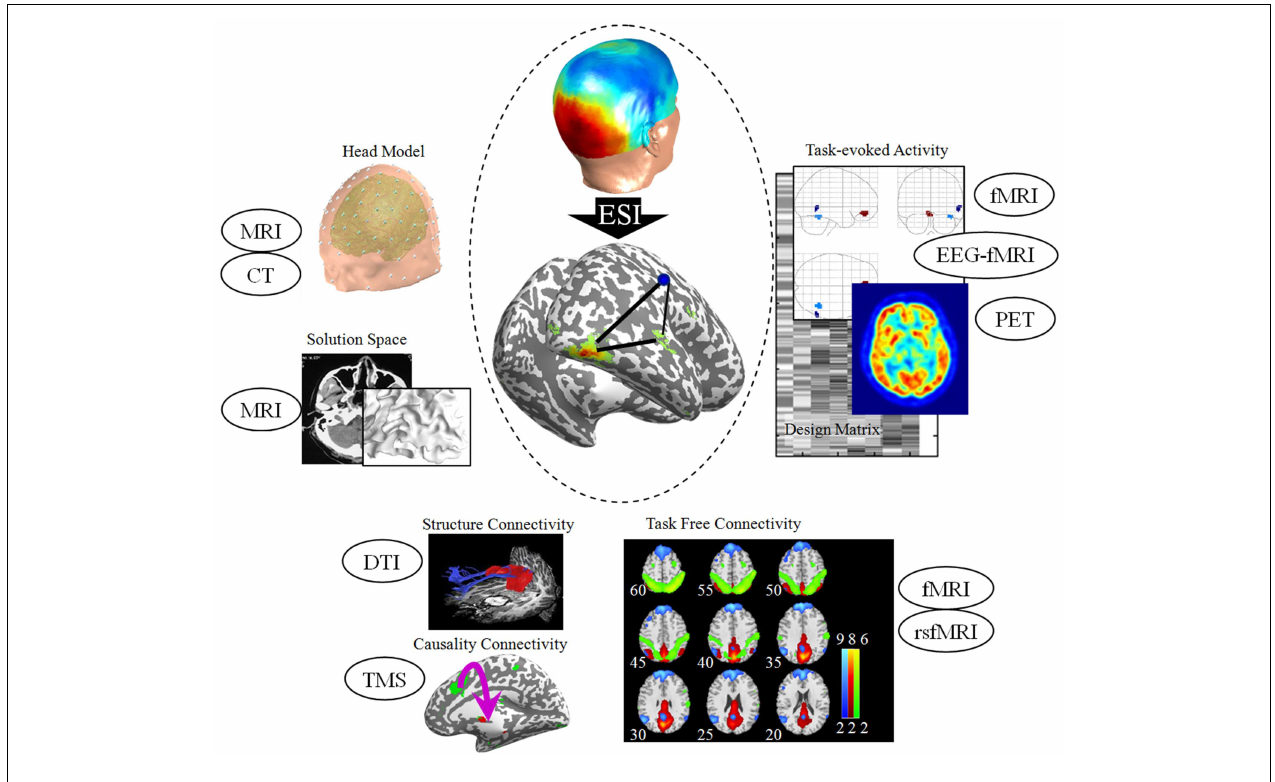
space. The TMS alters cortical excitability, effective connectivity, and oscillatory tuning of a given cortical area, and hence provides both spatial and connectivity priors for ESI. All the sources are from our unpublished experimental data. MRI, magnetic resonance imaging; CT, computed tomography; EEG, Electroencephalography; ESI, EEG source imaging; fMRI, functional MRI; PET, positron emission tomography; DTI, diffusion tensor imaging; TMS, transcranial magnetic